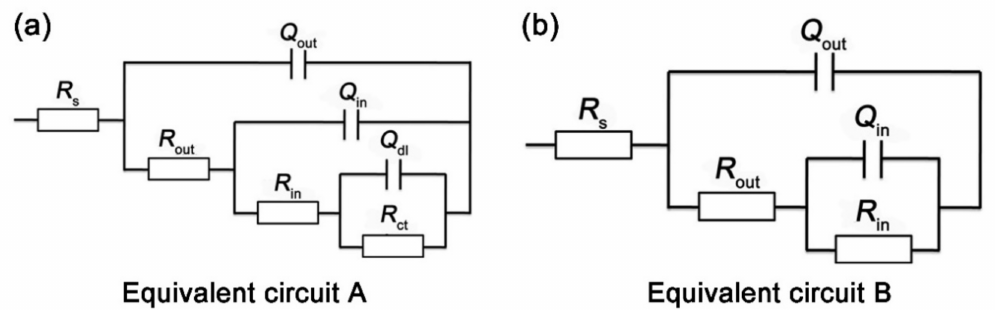
Figure 8. General model of the equivalent circuits used to fit the EIS data. ( a ) Equivalent circuit A, ( b ) Equivalent circuit